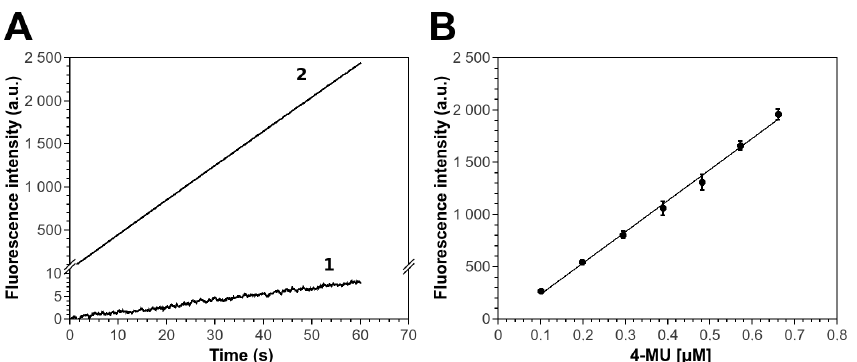
Figure 1. EST2 assay using 4-MUBu. ( A ) Fluorescence development of 4-MUBu by spontaneous hydrolysis in HEPES bu ff er (curve 1) and enzymatic hydrolysis after the addition of EST2 (curve 2). ( B ) Calibration curve of fluorescence intensity at increasing concentration of 4-MU in HEPES bu ff er for the calculation of the coe ffi cient value necessary for the determination of the amount of reaction products from the enzymatic hydrolysis (R square value for the regression line = 0.996). The error bars represent the standard deviation (SD) from three independent experiments.